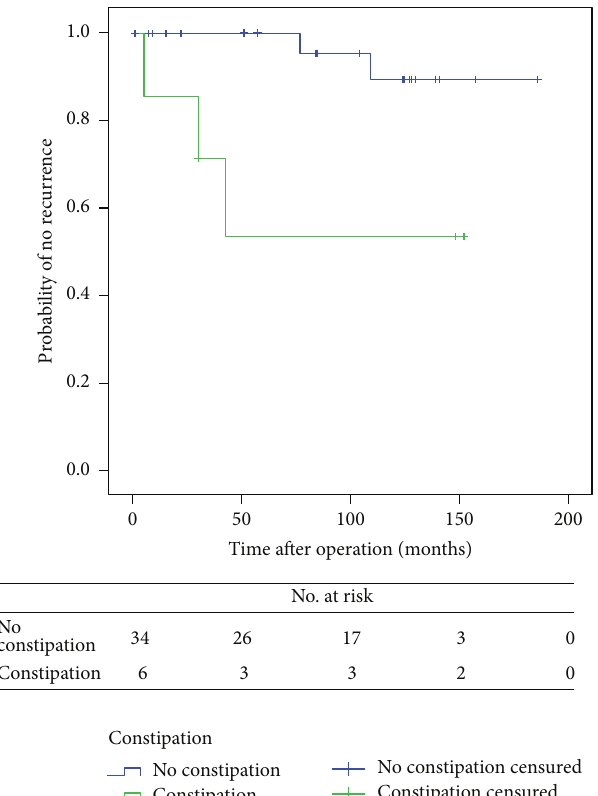
Figure 3: Comparison of probability of no recurrence with time for patients according to constipation (Kaplan-Meier